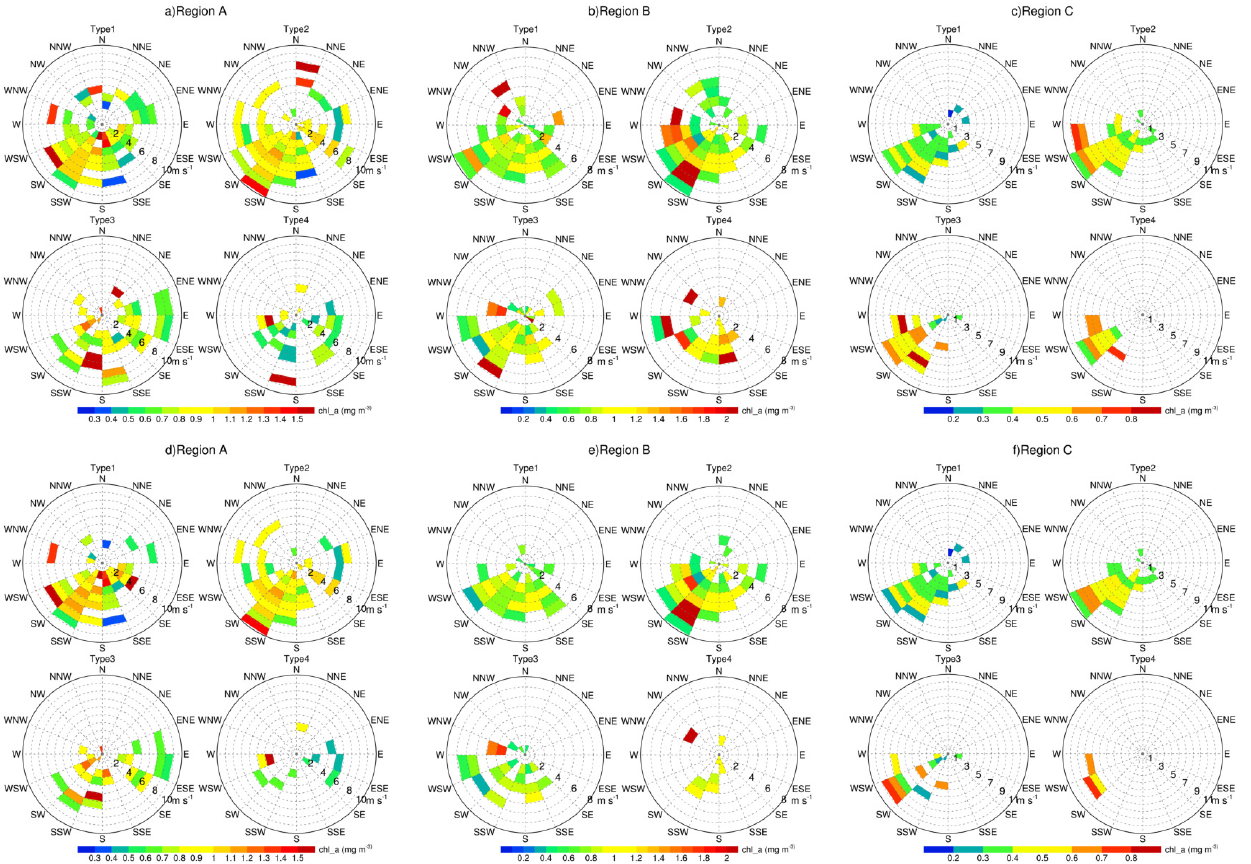
Figure 13. Wind roses of the chl-a concentration and wind field of the four weather patterns in the three regions shown in the black box in Figure 3d (Regions A/B/C). Average chl-a concentration and wind in the summers of 2015–2018: ( a ) Region A; ( b ) Region B; ( c ) Region C. Average chl-a concentration and wind field with typhoon effects removed, in the summers of 2015–2018: ( d ) Region A; ( e ) Region B; ( f ) Region C.